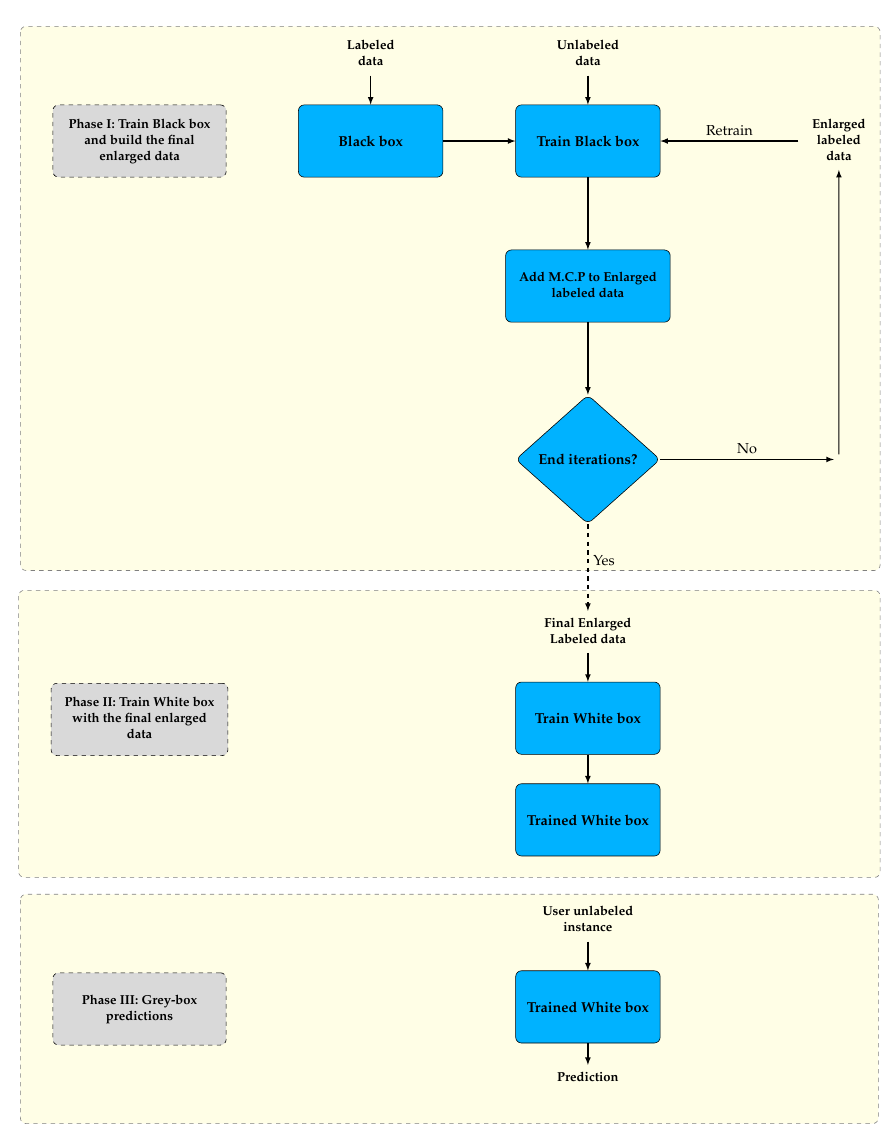
Figure 2. Grey-Box model flow